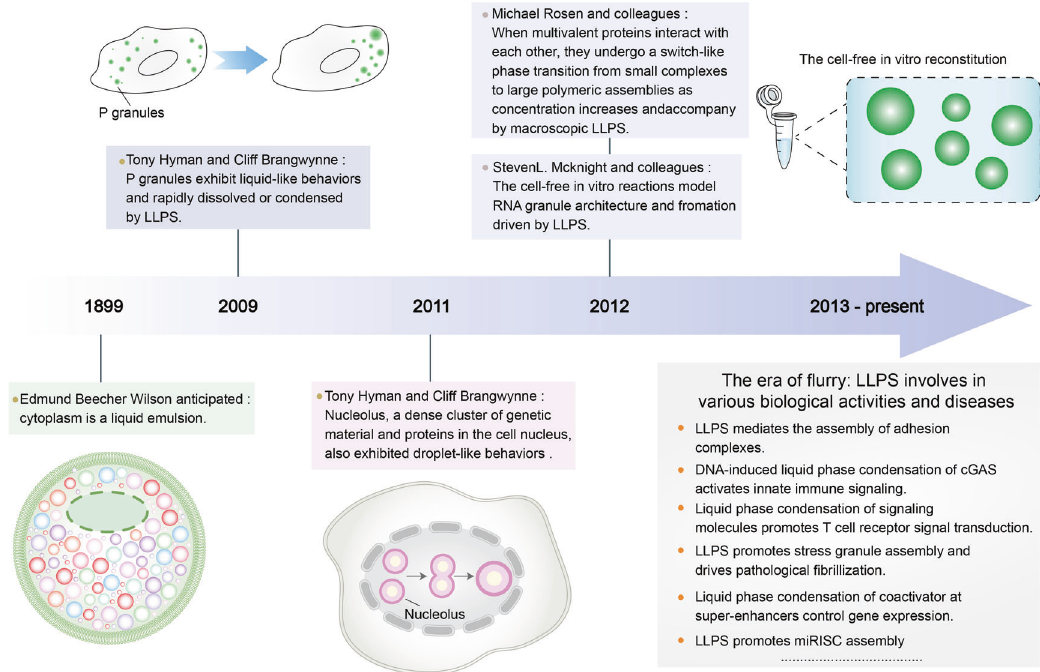
Fig. 1 History of the discovery and development of LLPS. Representative milestone fi ndings promoting the development of LLPS are enumerated in the fi